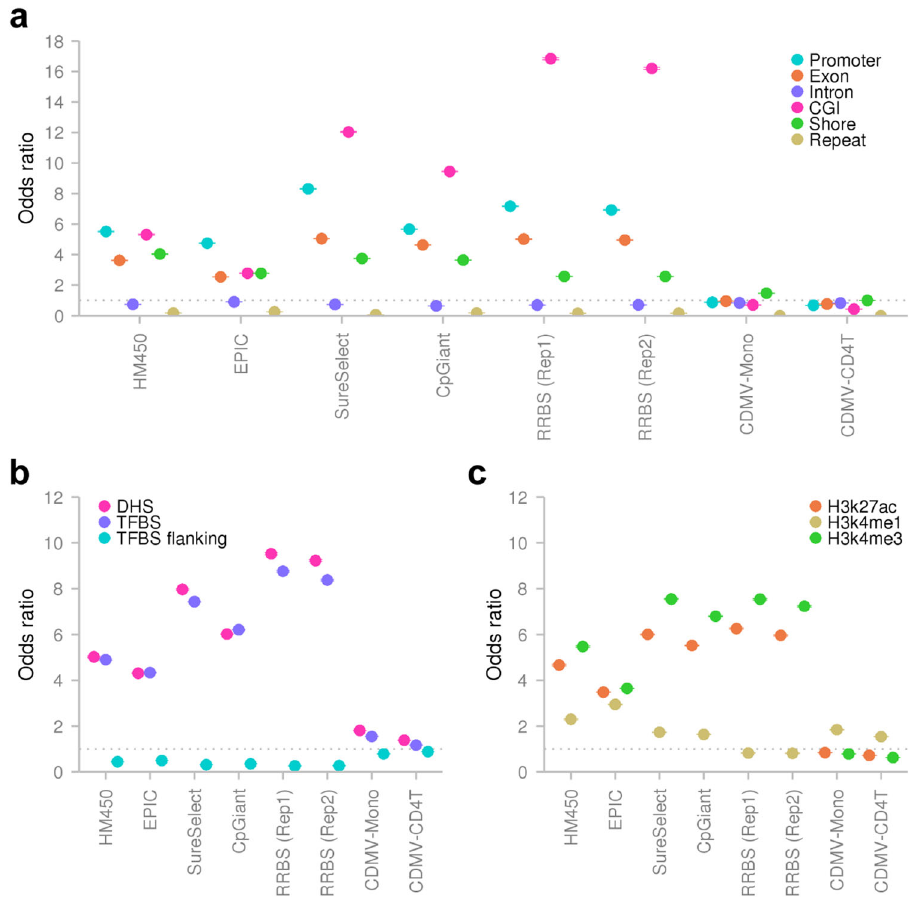
Fig. 8 Contents of regulatory elements in previous and proposed designs of target CpG sites. Enrichment for regulatory elements in each set of target CpG sites is shown. The ORs was estimated by comparing the proportions of CpG sites that overlapped with regulatory annotations in each set. The background proportion was calculated from all CpGs in the human reference genome (hg19). CGI CpG island, CpGiant SeqCap Epi CpGiant, DHS DNase I-hypersensitive site, H3K27ac histone H3 acetyl Lys27, H3K4me1 histone H3 monomethyl Lys4, H3K4me3 histone H3 trimethyl Lys4, HM450 HumanMethylation450, Rep , replication, RRBS reduced-representation bisul fi te sequencing, SureSelect SureSelect Human Methyl-Seq, TFBS transcription factor binding site